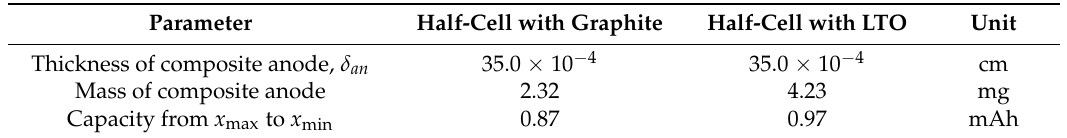
Table 4. Adjusted thickness of the simulated graphite composite anode for the purpose of comparing the simulated performance of graphite and LTO half-cells.